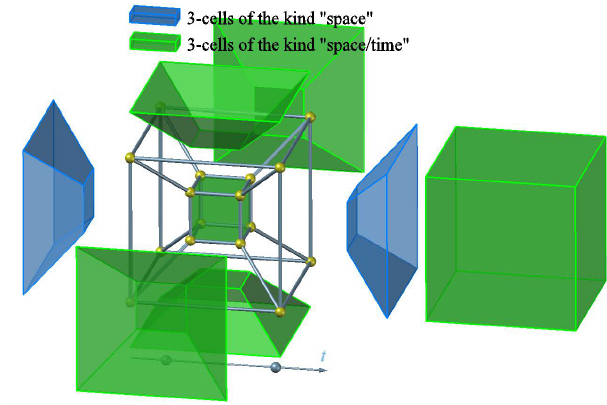
Figure 68: Different kinds of 3-cells in a space/time tesseract.